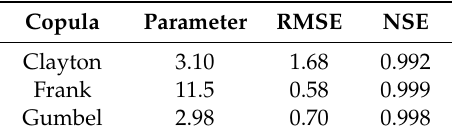
Table 6. Parameters of the Archimedean copula estimation from the pair of values of maximum annual peak-flows and maximum annual volumes of the continuous simulation, with the root mean square error (RMSE) and Nash–Sutcli ff e error (NSE).